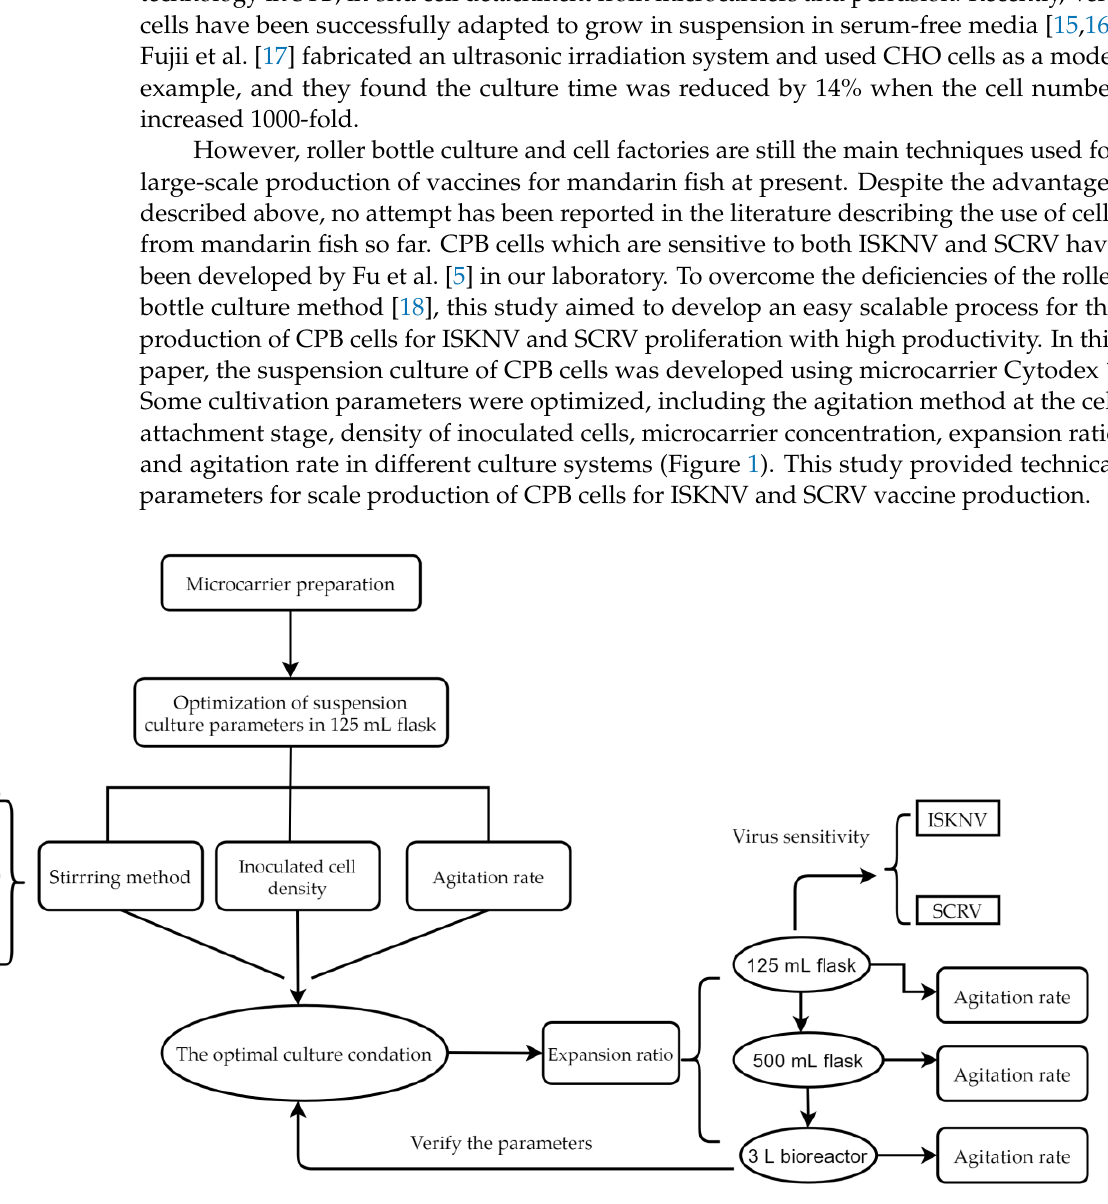
Figure 1. Flow diagram for the experimental process.